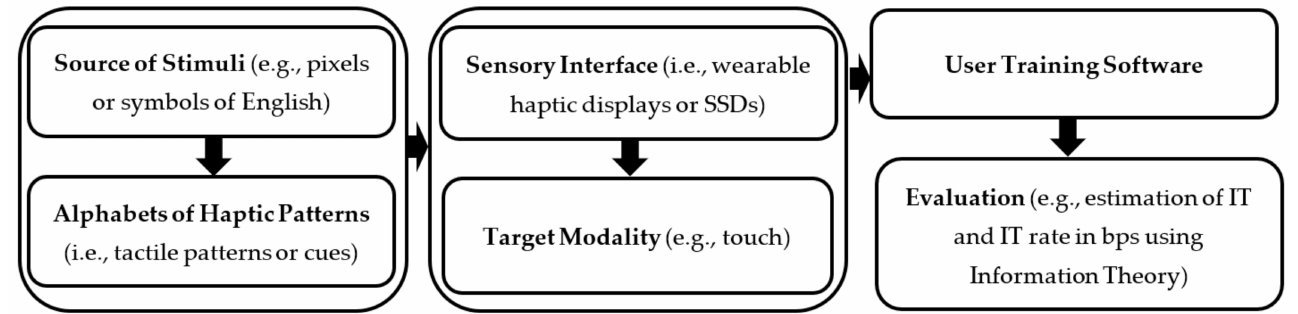
Figure 1. Key components of generic sensory substitution